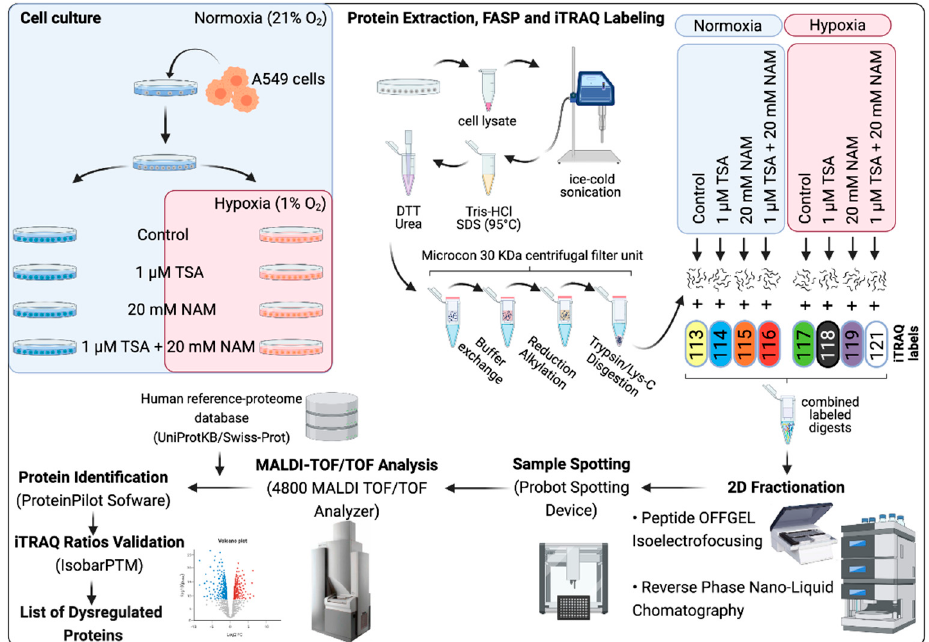
Figure 8. Schematic workflow of the proteomic approach used in the present study. A549 cells were treated with 1 μ M of TSA, 20 mM of NAM and both 1 μ M TSA and 20 mM NAM for 24 h under normoxia and hypoxia. Cells incubated in medium without KDACIs served as control. Cell lysates were processed according to the filter-aided sample preparation (FASP) protocol. Digested peptides of each treatment group were labeled with iTRAQ tags and separated in a 2-step fractionation. Fraction peptides were spotted on MALDI plates using a spotting system. Mass spectrometer 4800 MALDI TOF/TOF analyzer was used to collect MS and MS/MS data for identify and quantify proteins. iTRAQ ratios were quantified and validated. Proteins with iTRAQ ratios > 1 and a p - value ≤ 0.05 were considered to be significantly increased whereas proteins with iTRAQ ratios < 1 and a p -value ≤ 0.05 were considered to be significantly decreased.